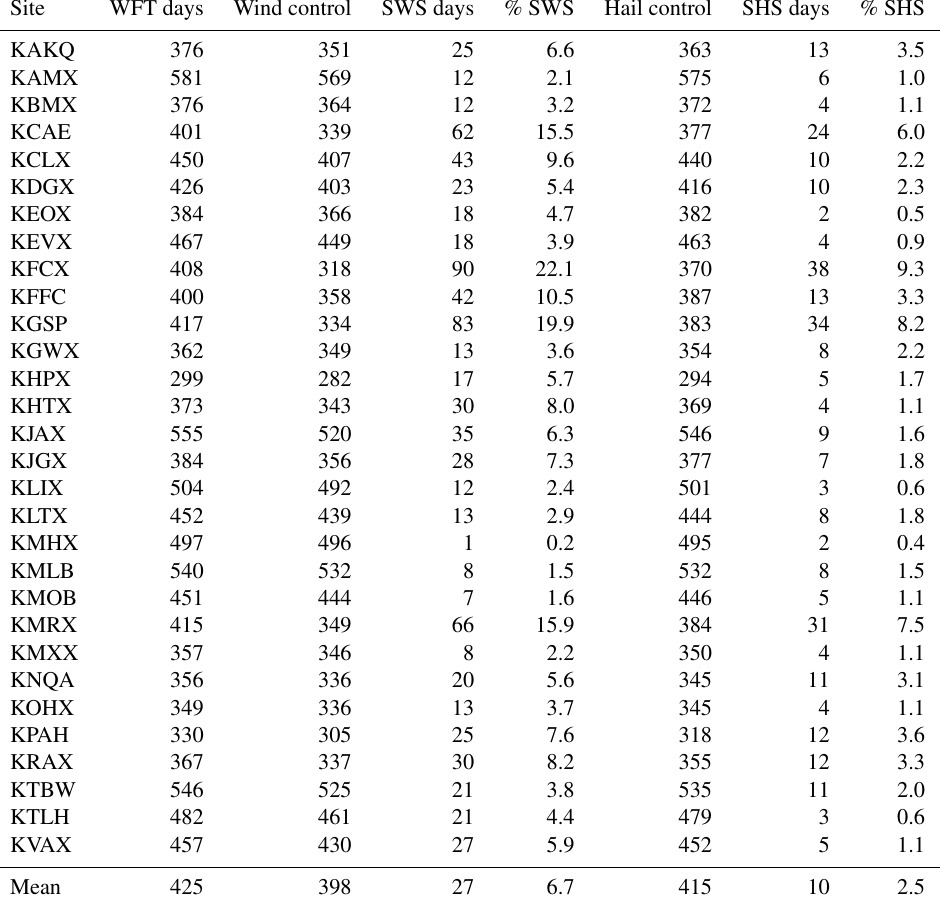
Table 4. WFT, SWS, and SHS day frequency by radar